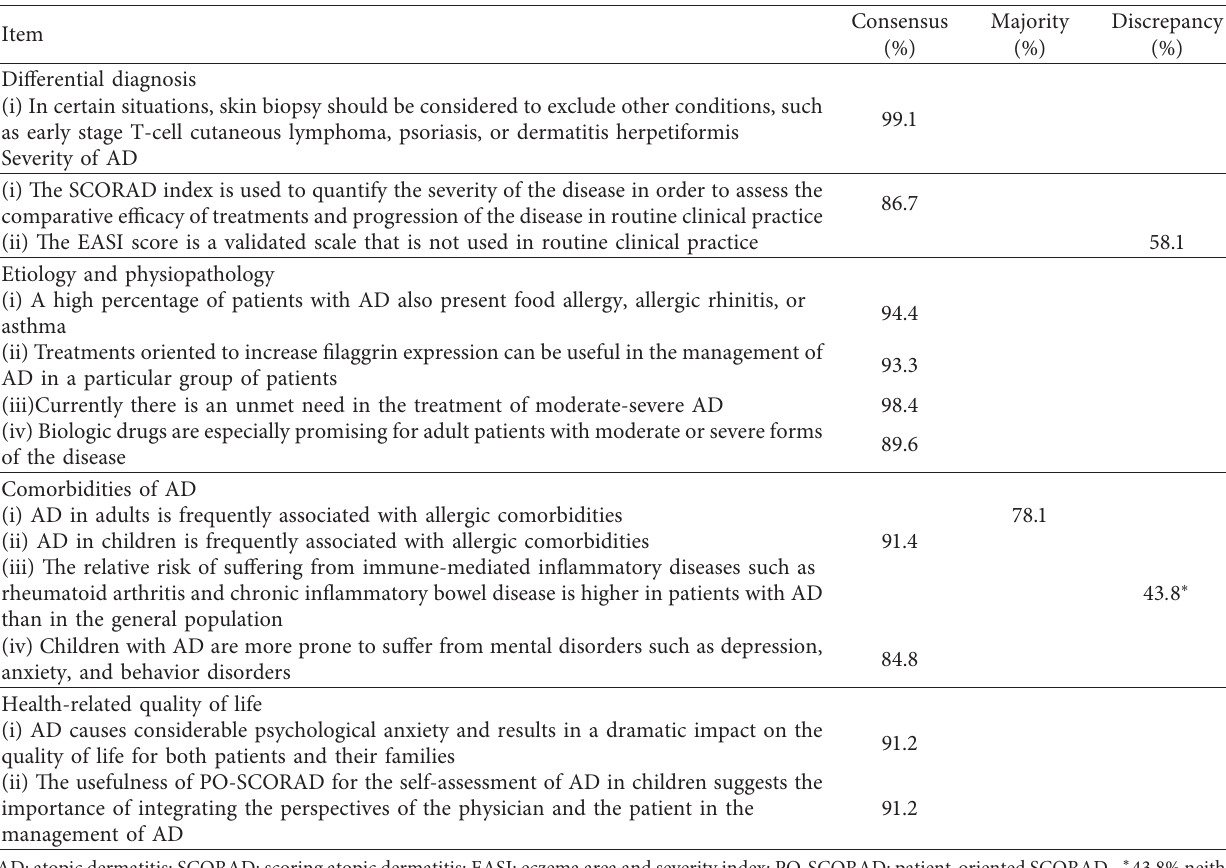
Table 3: Results regarding differential diagnosis, severity of AD, etiology and physiopathology, comorbidities, and health-related quality of